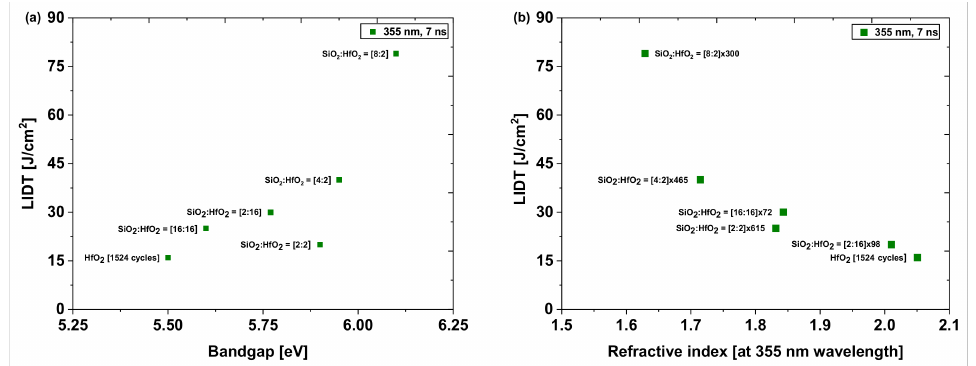
Figure 12. ( a ) LIDT vs. bandgap of various SiO 2 :HfO 2 heterostructures; ( b ) LIDT vs. refractive indices of various SiO 2 :HfO 2